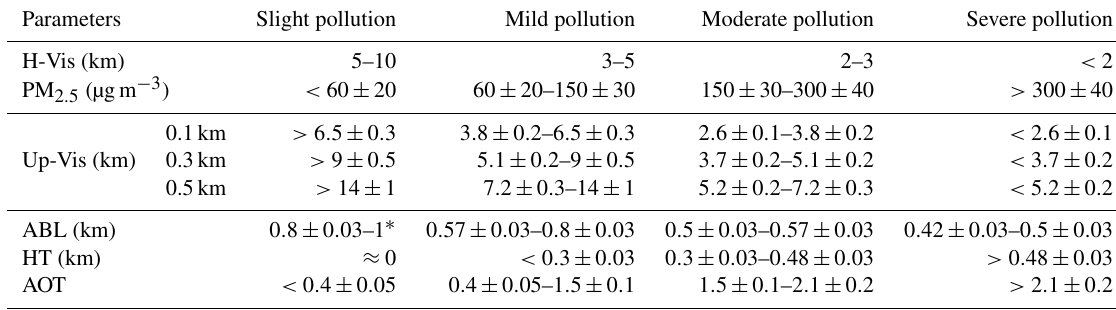
Table 2. Values of haze parameters and meteorological elements corresponding to the haze levels.